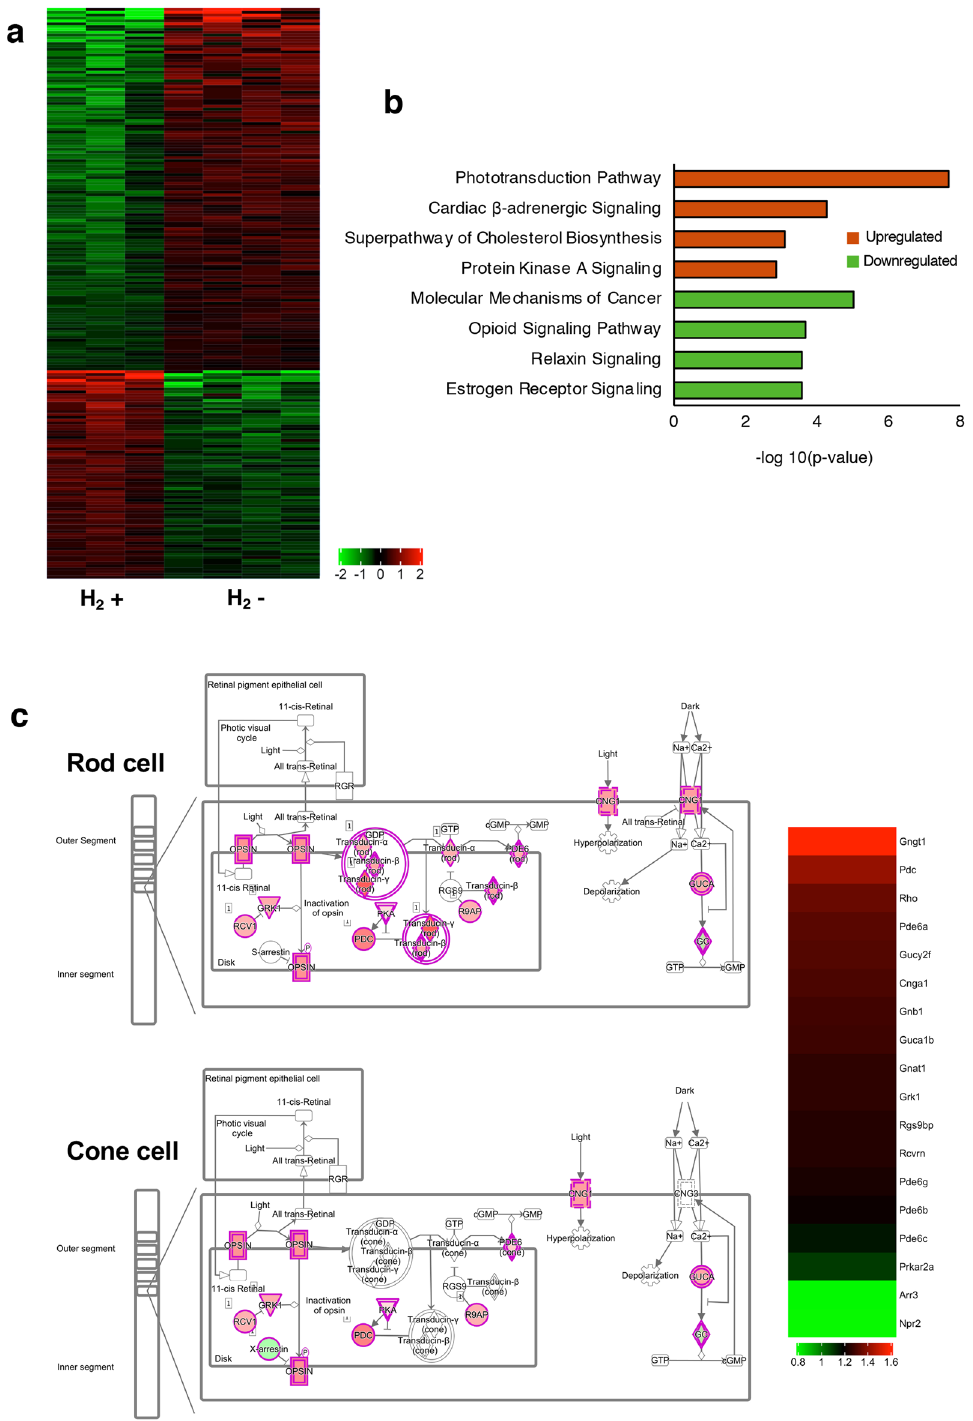
Figure 6. RNA-seq analysis. ( a ) Heatmap based on differentially expressed genes. Each column represents a sample (H 2 group: n = 3; control group: n = 4), and each row represents a gene. The expression level of each gene in a single sample is depicted according to the color scale. ( b ) Pathway analysis of the differentially expressed genes based on IPA. The top four most significant up- and downregulated pathways after drinking H 2 water. ( c ) IPA pathway and heatmap of phototransduction. Red and green colors indicate that the genes are upregulated or downregulated,